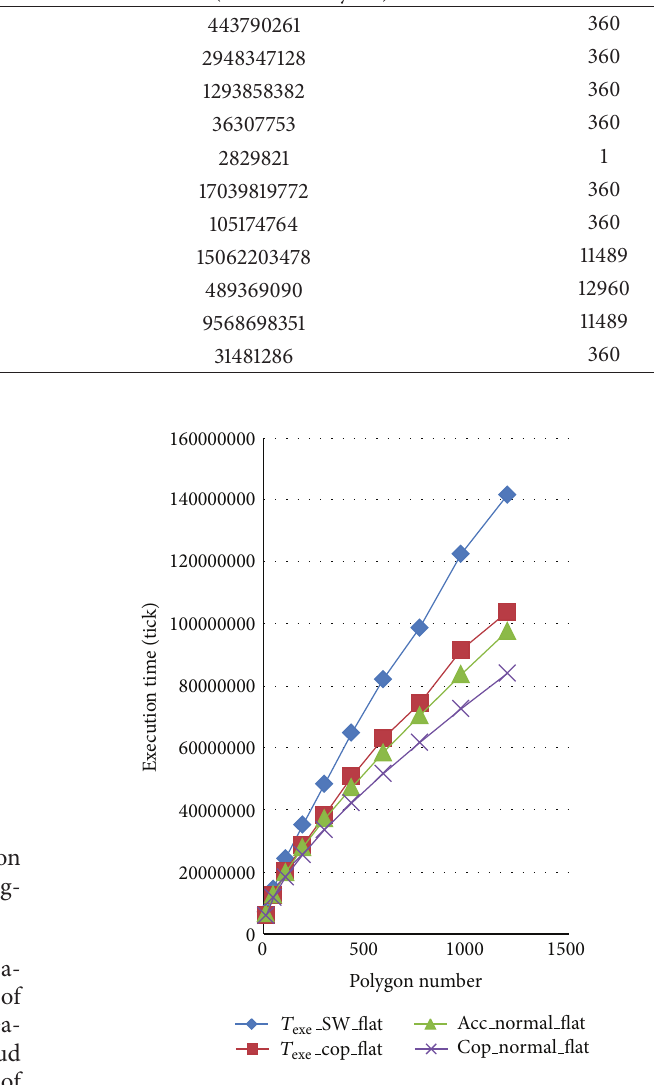
Figure 9: 𝑇 /Poly nb variation for flat exe